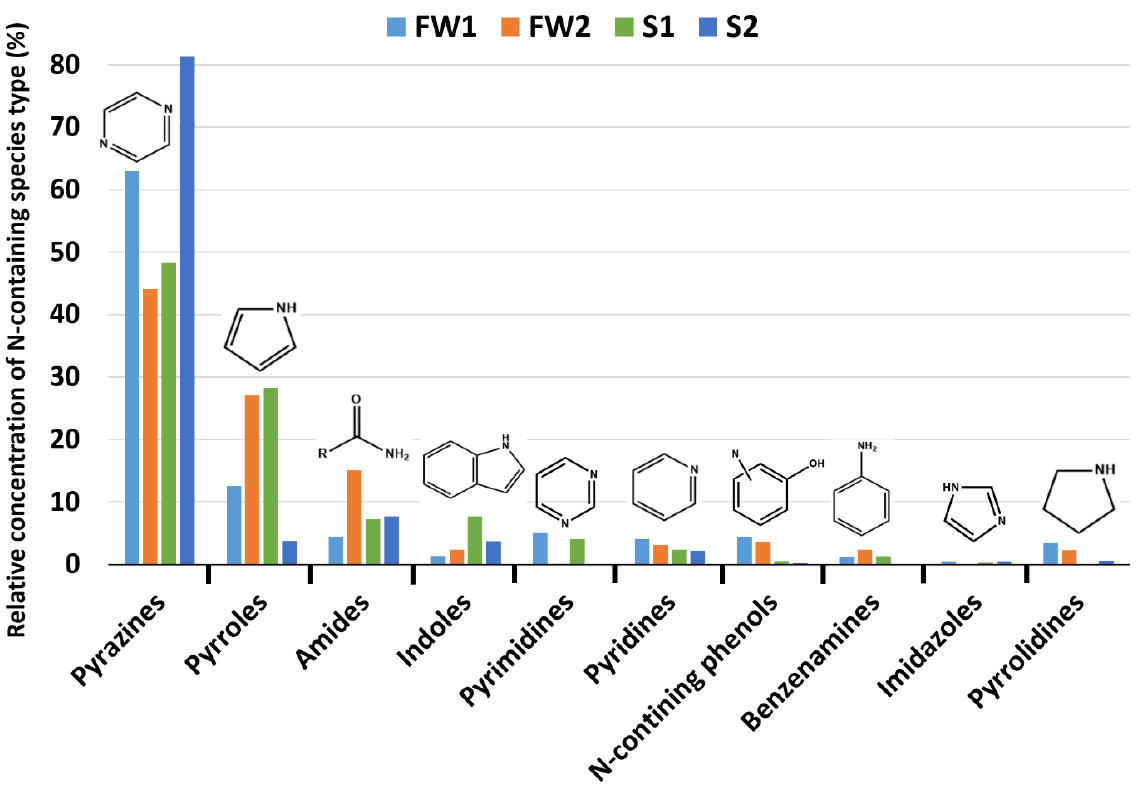
Figure 3. The relative concentrations of the major classes of nitrogenates present in each of the 4 WWHTLBs produced in this study, as determined by 2D-GC-MS.